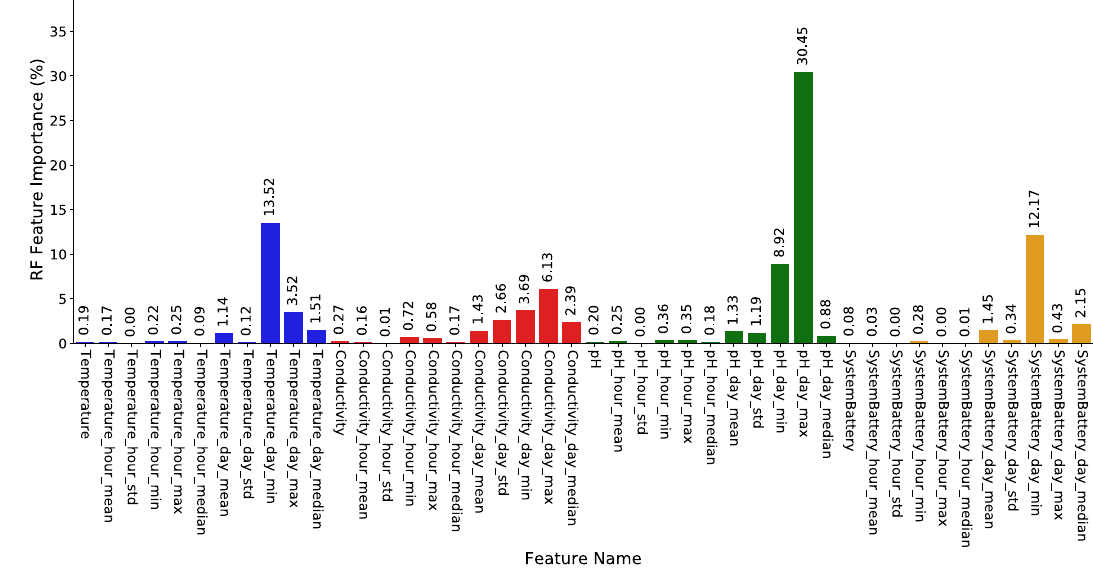
Figure 13. Feature importance generated by the best Random Forest model for Chl- a prediction using original and augmented input features. Experiment